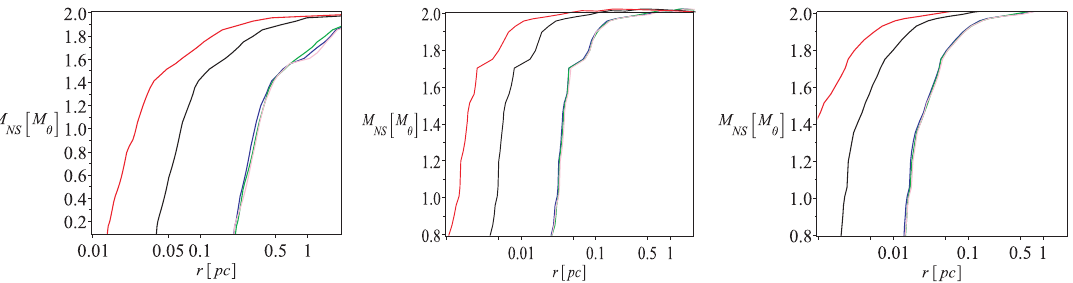
Figure 3. The NS mass changes due to DM accumulation in terms of distance from the galactic center, for cross section 10 − 45 , particle mass m dm = 500 ( left panel ), 200 ( central panel ), 100 ( right panel ), and for y = 0.1. The colours correspond to those used in Figure